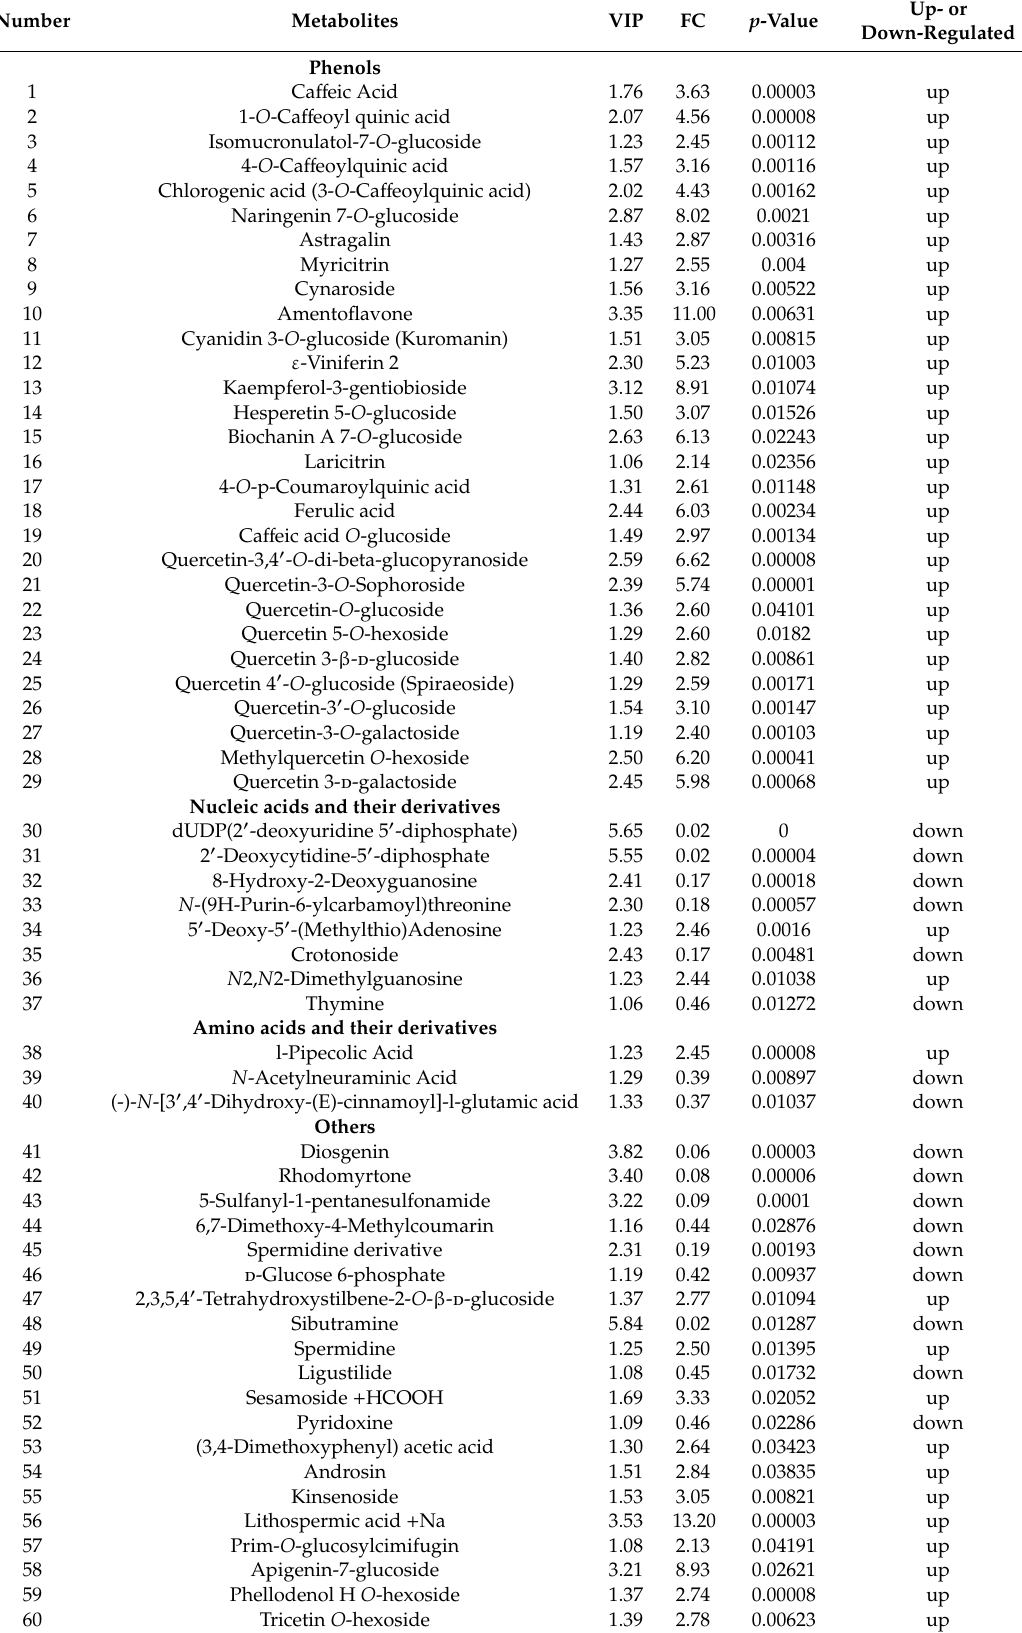
Table 6. Significantly di ff erent metabolites in the russet CKY versus non-russet CKN comparison.